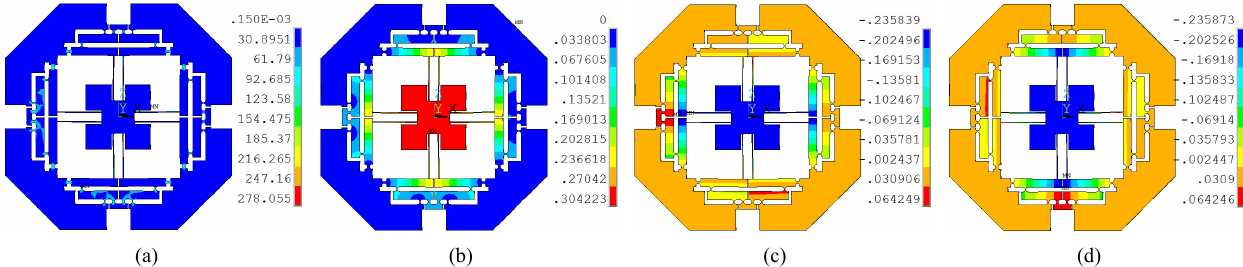
Figure 10. The stress distribution and deformation diagrams: (a) maximal stress; (b) total output displacement; (c) output displacement at x -direction; (d) output displacement at y -direction.